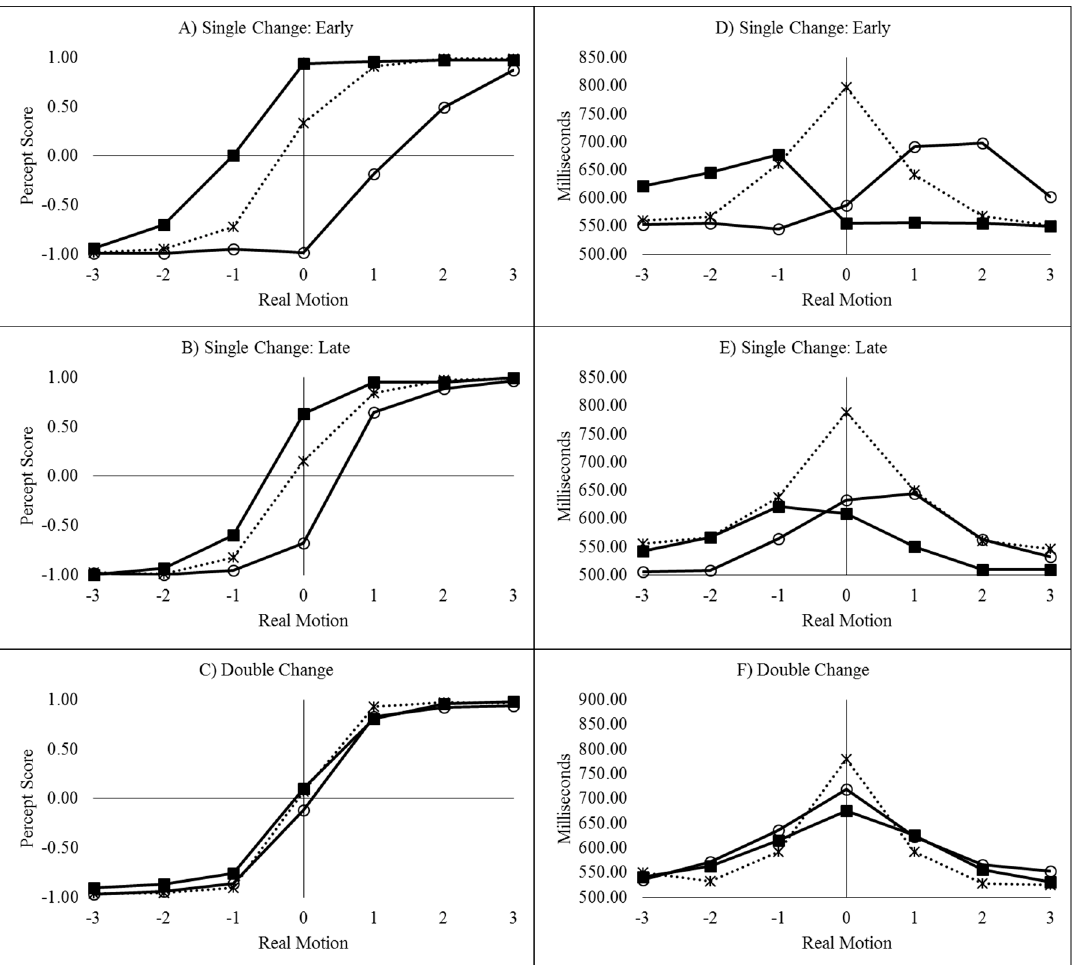
Figure 5. Mean perception scores ( A – C ) and decision times ( D – F ) from Experiment 2 for left (solid lines with filled squares), right (solid lines with open circles), and no flash conditions (dashed lines with asterisks) for the early (A and D), late (B and E), and double (C and F) change conditions.